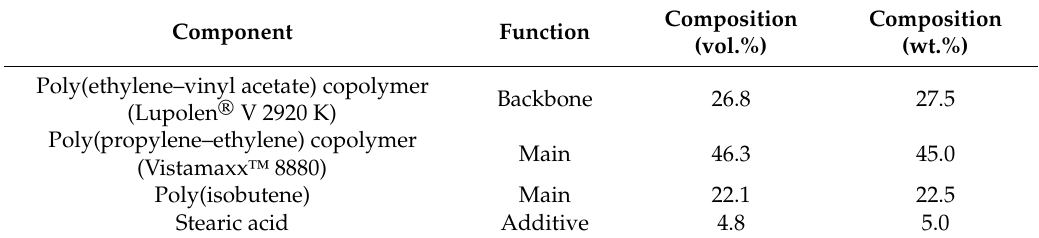
Composition Composition (vol.%) (wt.%)